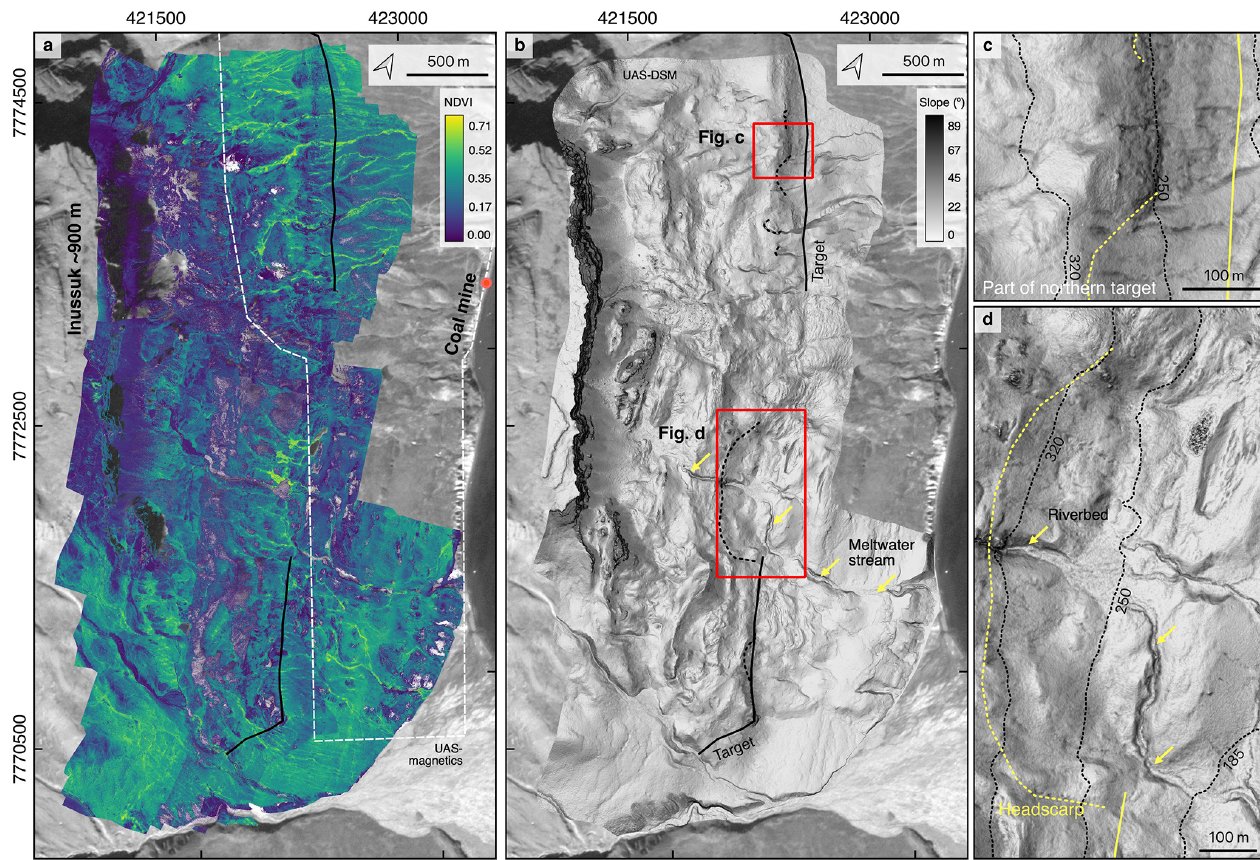
Figure 8. Images derived from the UAS multispectral and photogrammetry data. (a) NDVI mosaic derived from the Sequoia camera scenes depicts vegetation occurrence. (b) Slope map (in degree) illustrates the amplitude of the topographic gradient. Inset maps show (c) close-up of the northern part from the targeted magmatic (sampled) and (d) detached blocks with the interpreted headscarp boundary, and a deeply incised meltwater